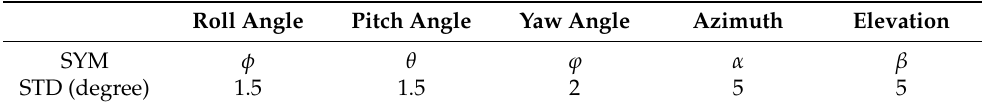
Table 2. Measurement noise setting.